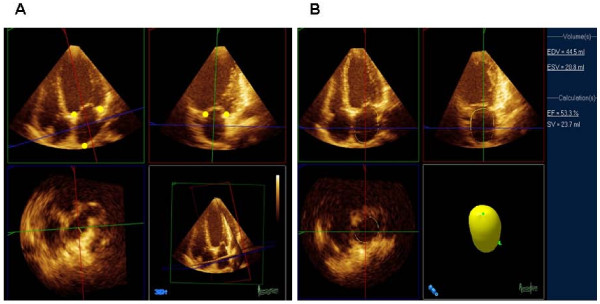
Semi automatic left atrial border tracing by marking (●) at 4 mitral annular points (lateral, septal, inferior, anterior) and an atrial superior dome point opposite the annulus (A). The automatic border tracing is then shown by the software. The left atrial end diastolic volume (EDV), end systolic volume (ESV) and ejection fraction (EF) are calculated automatically by the software and displayed on the right side of the screen (B). SV = stroke volume.